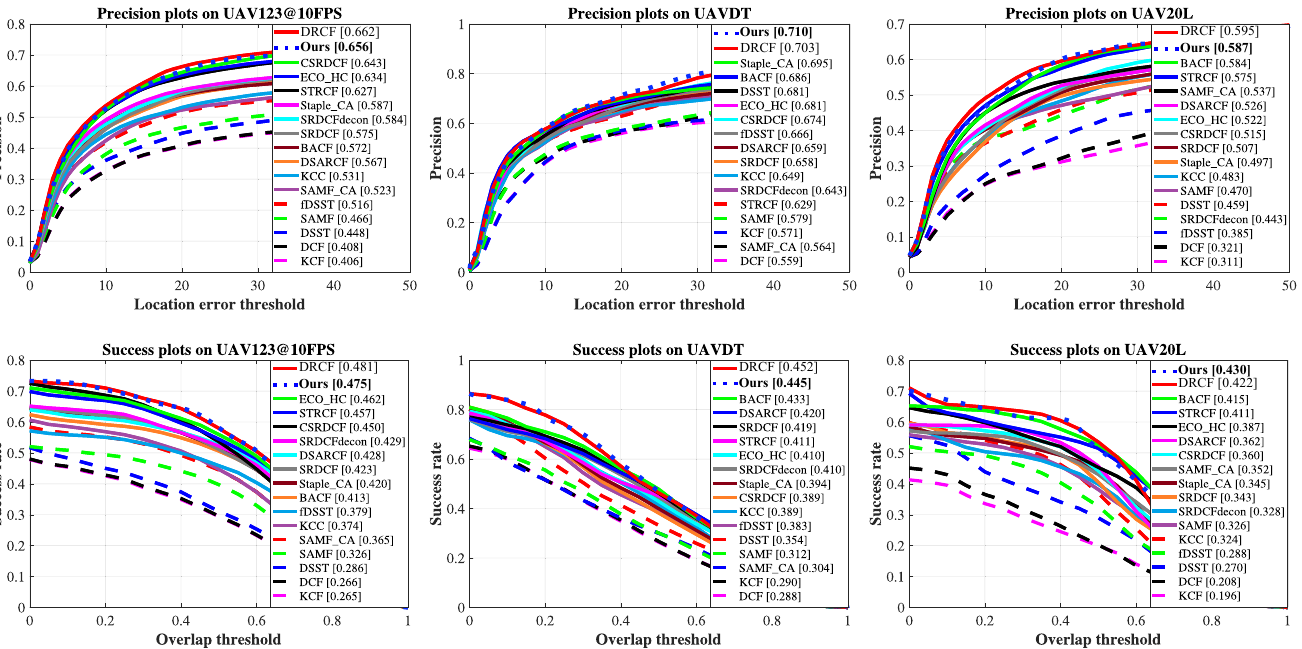
Figure 8. Tracking results obtained in the experiments. In the first row, Precision plots are provided, while, in the second row, the Success plot are shown. The results obtained by the 16 tracker, which we used for comparison, are taken from